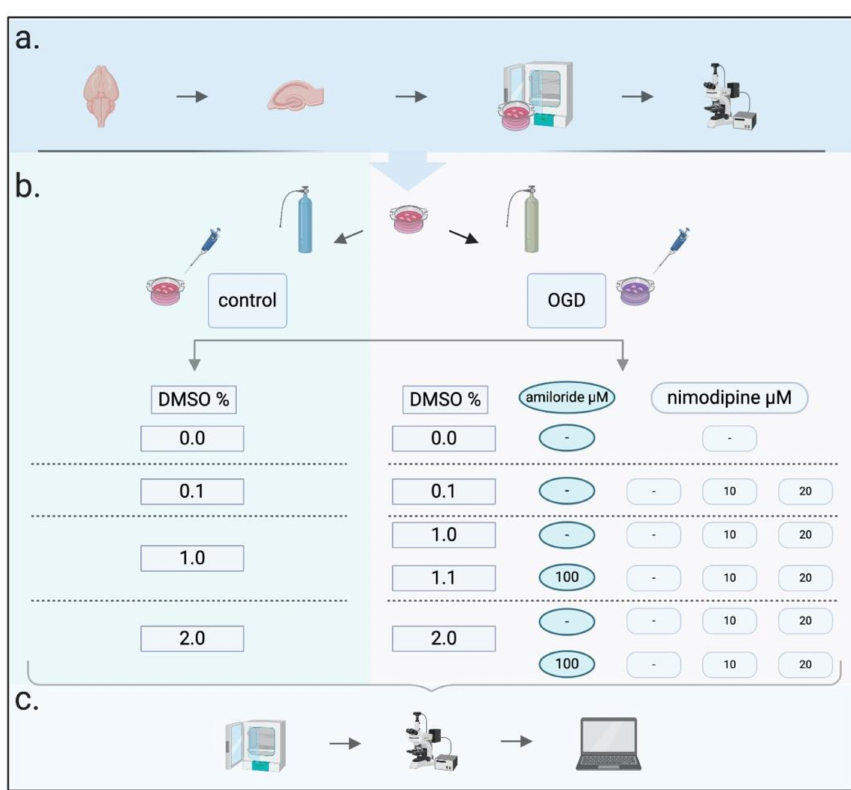
Figure 6. Experimental design. ( a ) Slice preparation, culturing for 14 days and baseline propidium iodide (PI) imaging. ( b ) OGD experiments with overview of experimental groups. ( c ) Incubation for 72 h after OGD, PI imaging for cell death assessment at 72 h, analysis of experimental groups. Created with